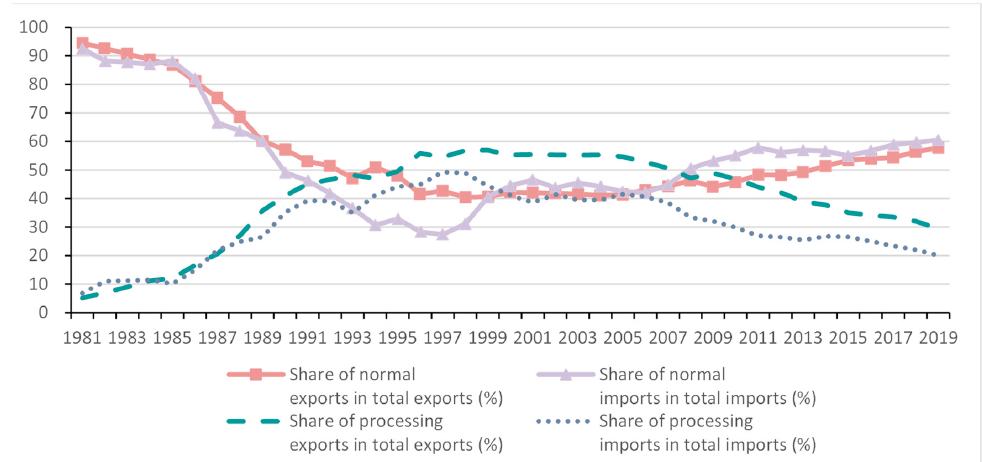
Figure 1. Share of normal and processing trade in China. Source: [14].